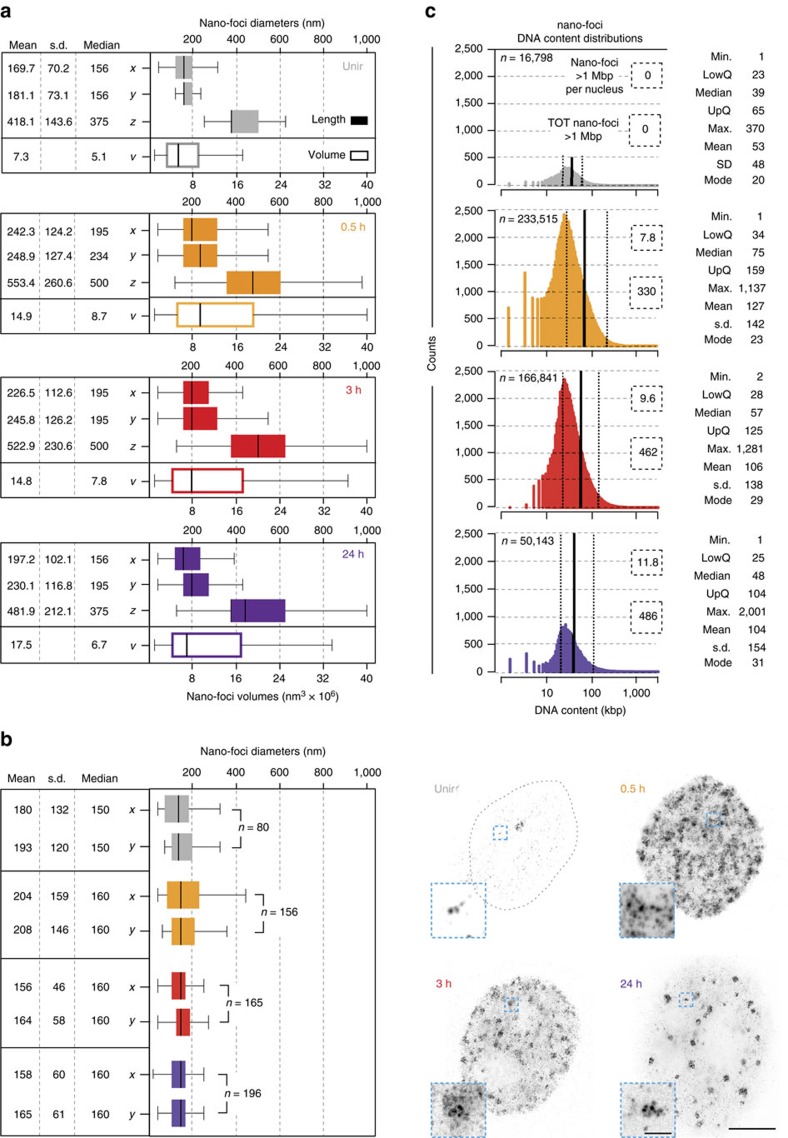
Metrics of γH2AX nano-foci dimensions and DNA content.(a) Quantification of nano-foci diameters in the three dimensions (filled boxes, top) during DDR. From these three dimensions, the volumes were calculated (empty boxes, bottom). The difference between lateral and axial measurements is due to the lower resolution in the axial direction. Figures in nm or nm3 × 106 are shown. (b) STED microscopy of γH2AX immunofluorescence. (left) Quantification of lateral diameters of γH2AX nano-foci. Statistics and size scale are as in a. (right) Exemplary STED images of cells before and after IR are shown together with the magnified views of the light-blue boxes. Scale bars, 5 μm and 500 nm for main micrographs and magnified regions, respectively. (c) DNA content distributions of γH2AX nano-foci before and during DDR. Only in IR-exposed cells, we found nano-foci larger than 1 Mbp (dashed boxes), and their frequency never exceeded 1% (0.14%, 0.28%, 0.95% for 0.5 h, 3 h and 24 h, respectively). Kruskal–Wallis χ2=18,503, df=3, P<2.2 × 10−16. Statistics (in kb) are shown next to each distribution. All boxes and whiskers are as in Fig. 1. n: total number of measured nano-foci from all imaged cells in two independent experiments, for 3D-SIM (a,c) or STED (b).